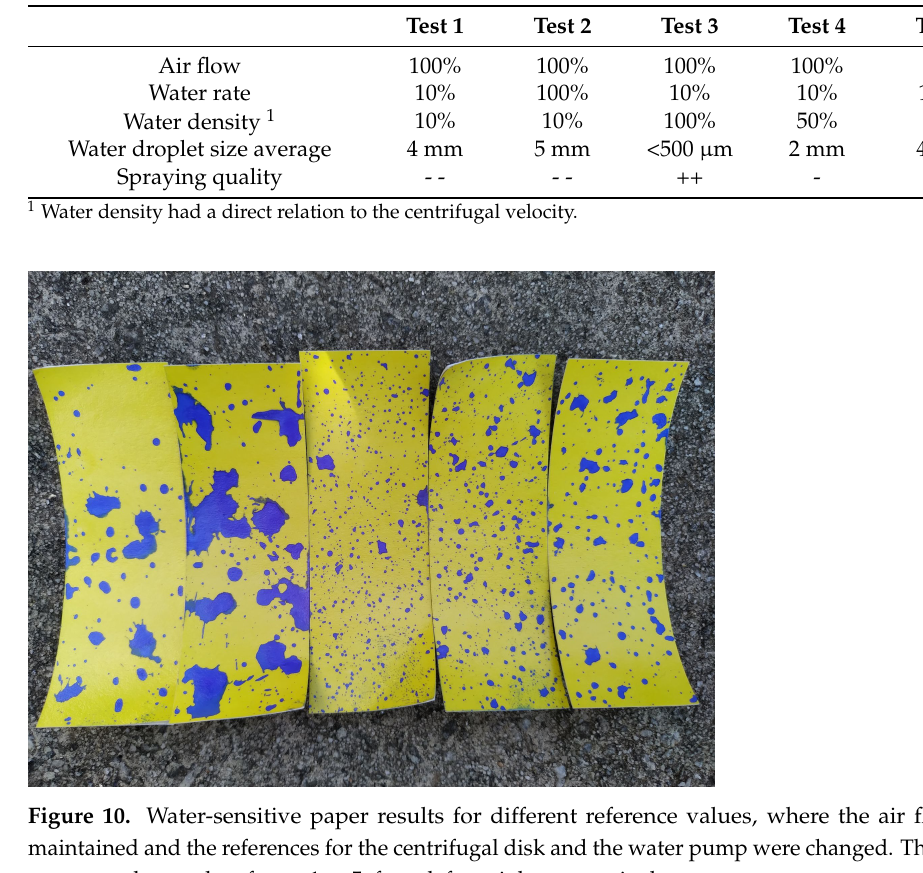
Table 6. Qualitative results for the PRYSM sprayer obtained for five tests.